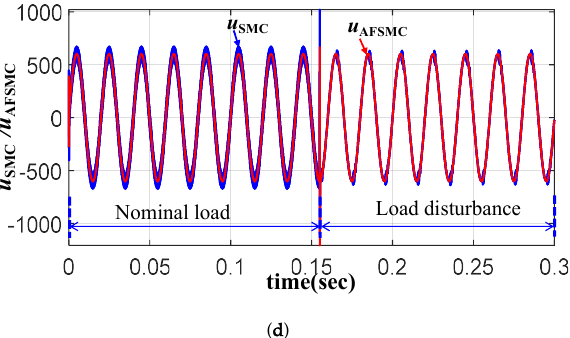
Figure 4. Simulated result under load disturbance from 25Ω to 50Ω.: (a) Output voltage ( v o ); (b) voltage tracking error by SMC ( ρ = 1.5) and proposed AFSMC; (c) voltage tracking error by SMC ( ρ = 10.5) and proposed AFSMC; (d) control effort by SMC ( ρ = 10.5) and proposed AFSMC.